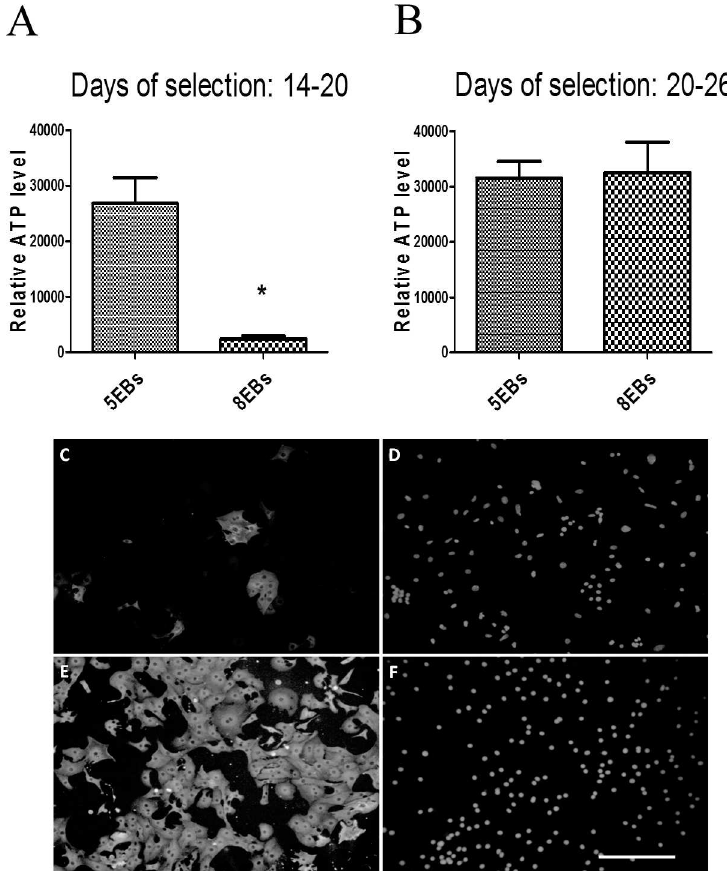
Fig 4. A numberof viablecardiomyocytesdetermined asthe levelof ATP in the HG8cloneof the R1ES cell(see methods)ratioin the culturederivedfrom 5- and8-dayoldEBs (A andB). Selectionof cardiomyocytesbyG418 antibiotics startedon days14 (Daysof selection: 14–20)and20(Daysof selection:20–26)of differentiation,and continued for 6 daysinboth cases.Dataareexpressed as mean ± SEM (n = 4). Differences betweensamples wereanalyzedby pairedT-test andconsidered statisticallysignificant for p (cid:20) 0.05;theyaremarkedwithasterisks. Thepurityof theselectedcardiomyocytesis alsoshown.Representative pictureof non-selected (C, D) and selected(E, F) cardiomyocytes stainedusingthe anti-MHCantibodyMF20(C, E) onday20of differentiation.Cell nucleiarecounterstained byDAPI (D, F). Scalebar= 100 μ m.